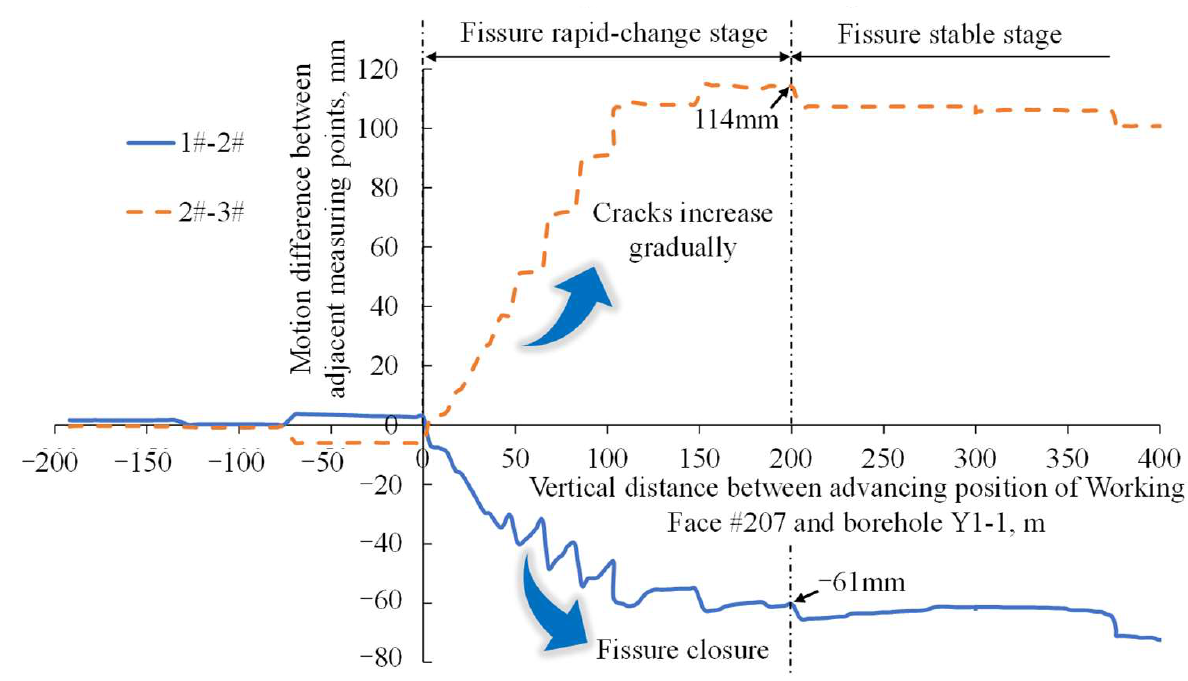
Figure 14. Variation of the difference value of two measuring points in the borehole with advancing.